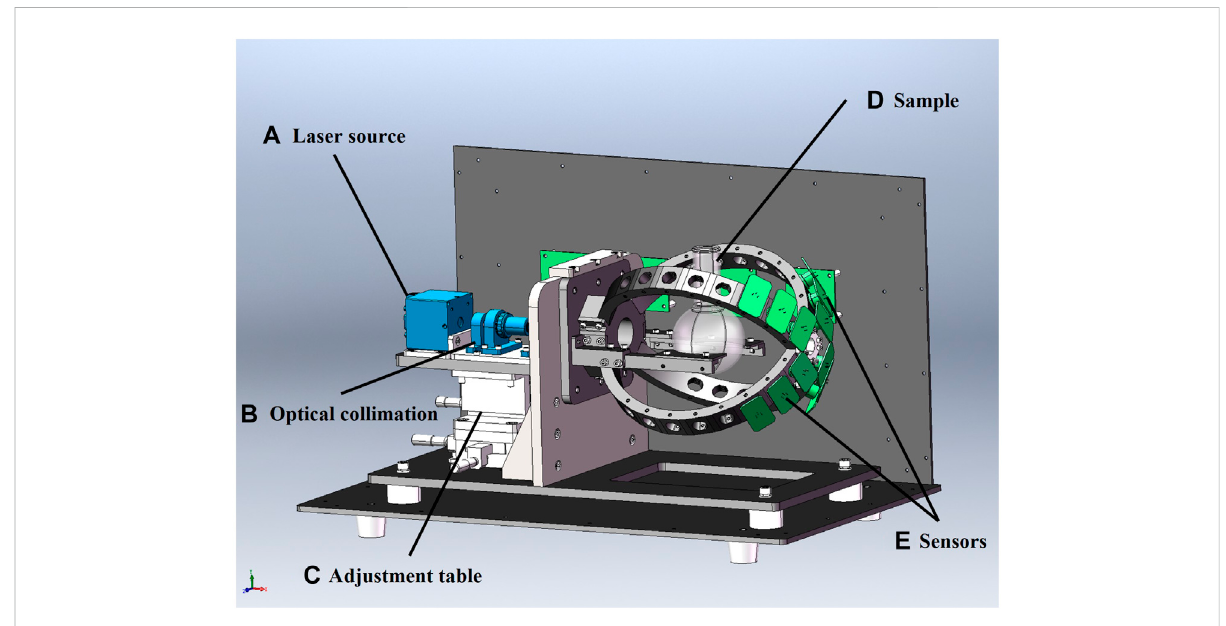
FIGURE 4 Prototype of the optical system designed by Soildworks 2020. (A) Laser source: Laser source with wavelength of 660 nm and power rating of 150 mWlasersourceswasusedtoemit laserbeam; (B) Opticalcollimation:Theoptimized collimationsystem wasusedto ensurethat thescattering light signal from the micro-particles was fully transmitted to the detector unit in real time. (C) Adjustment table: The 3-axis positioning system was usedtoadjustthepositionofthehorizontalxandyaxisandtheverticalzaxissothatthelaserbeamcanbefocusedonthecenterofthesample. (D) Sample:DifferentconcentrationsofmicroparticlesamplesmixedwithDIwaterwaspreparedasexperimentalsamples. (E) Sensors:Aphotodiode with wavelength range of 350 – 1,100 nm and rise time of 10 ns was implemented to convert the light signal to an electrical